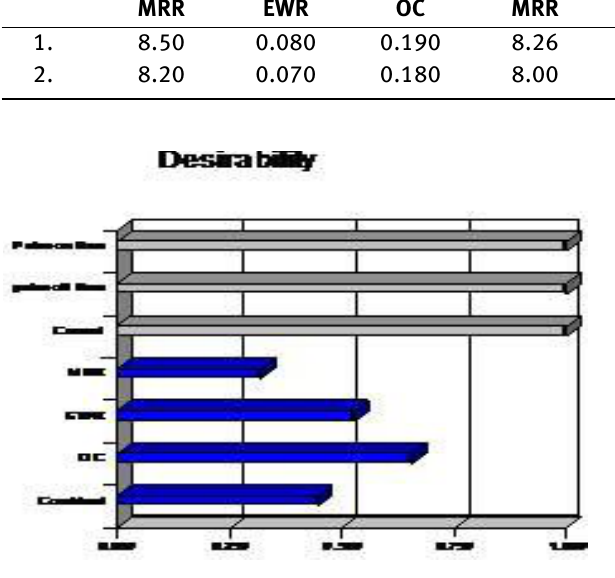
Figure 17: Bar Graph showing desirability for MRR; EWR and Overcut